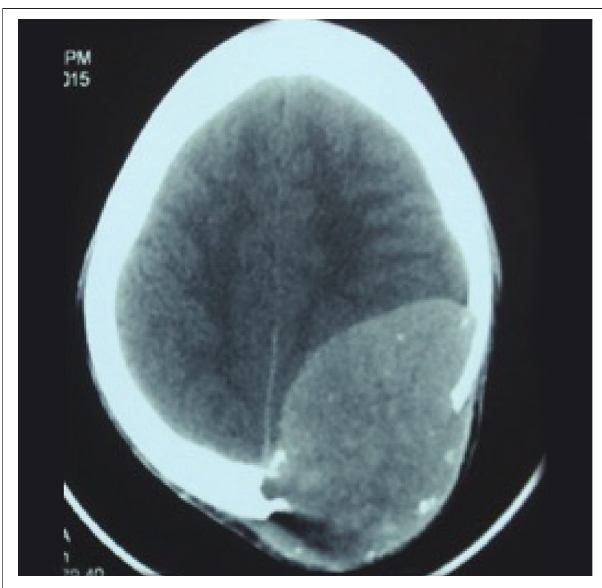
FIGURE 3: Axial T1-weighted MR image shows a heterogeneous mass lesion in left parietal bone causing bone destruction.